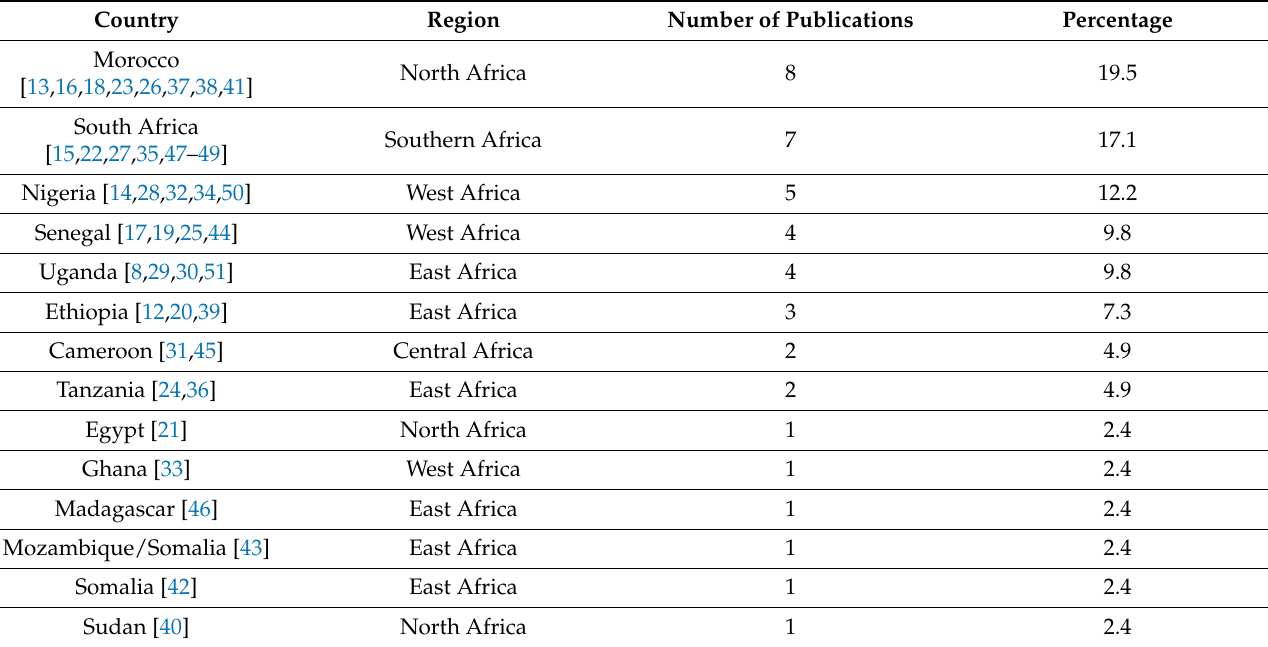
Table 1. Distribution of the studies included in the review.